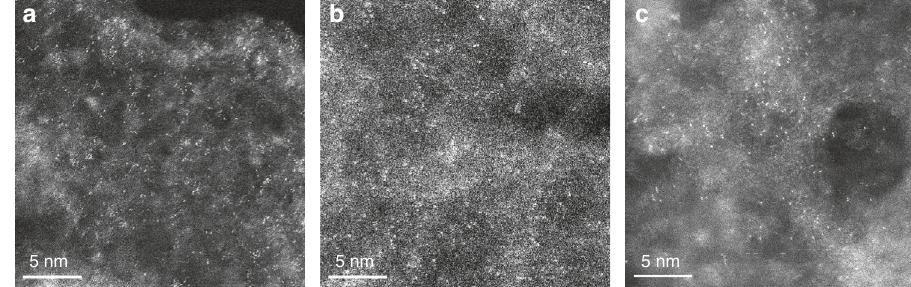
Fig. 5 HAADF-STEM images. a Pd 1 /hNCNC. b Au 1 /hNCNC. c Ir 1